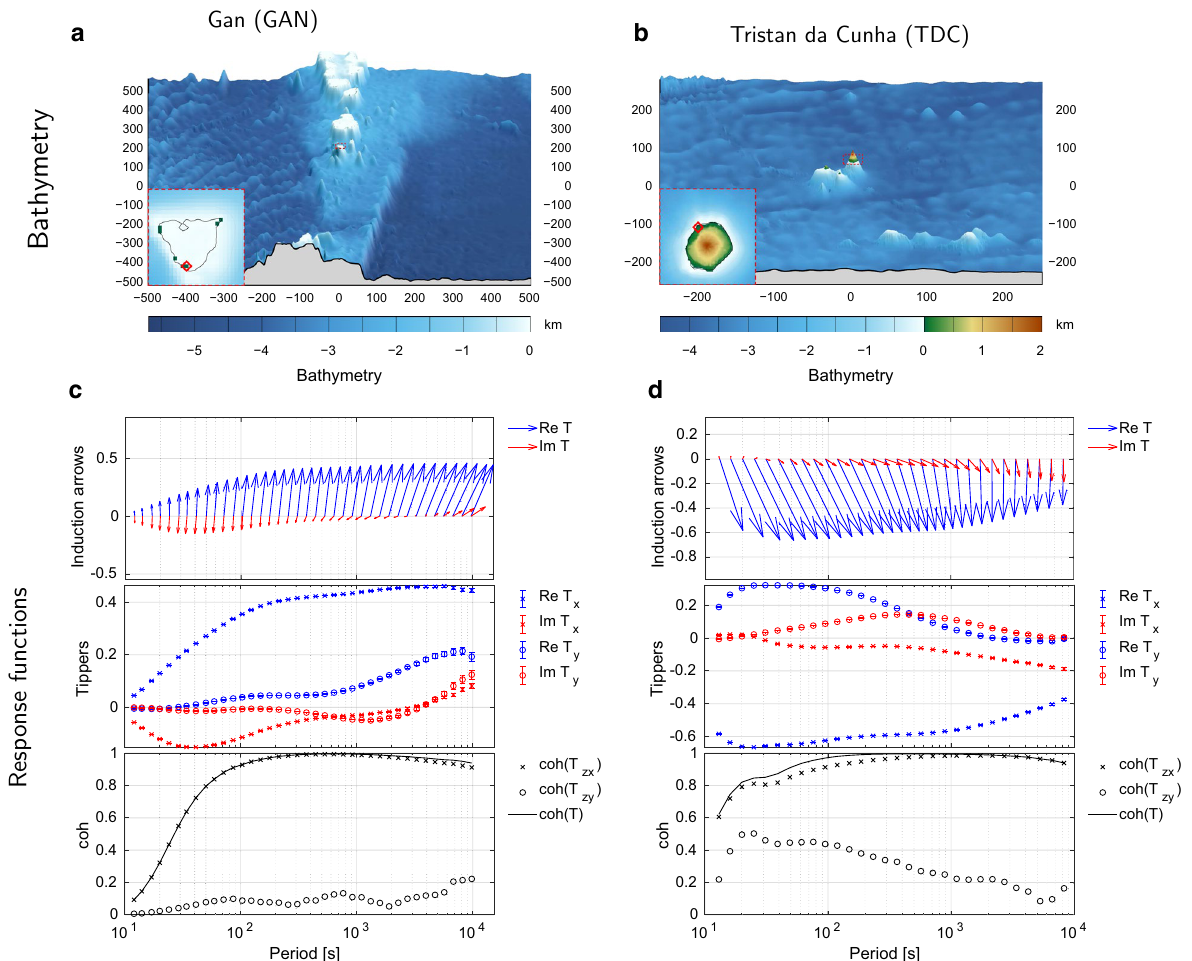
Fig. 3 Short title: Bathymetry with response functions Detailed legend: The bathymetry (GEBCO30) for the GAN ( a ) and TDC ( b ) observatories is shown for the area used for numerical modeling, and the location of the observatories is indicated by a red diamond in the inlets. Please note that the Addu Atoll is barely above sea level, and green points mark these regions whereas the black line also includes regions down to 30 m below sea level. In the lower panels, the observed induction arrows, tippers, and coherencies are shown for the GAN ( c ) and TDC ( d ) observatories. As expected, the real (blue) induction arrows point toward the more resistive